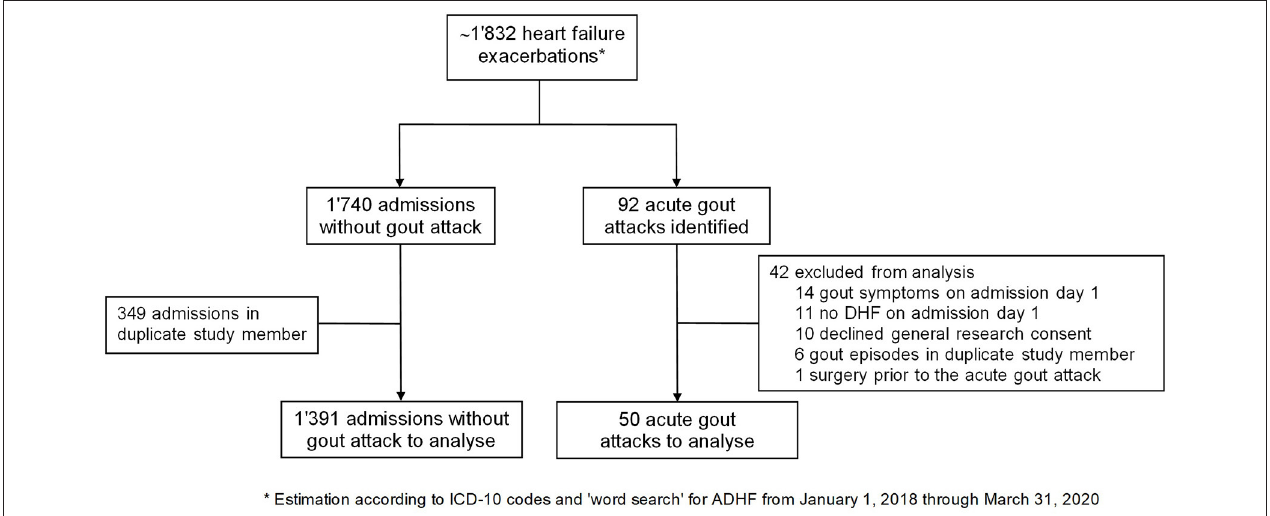
FIGURE 1 | Flowchart of patient selection. ADHF, acute decompensated heart failure; ICD, International Statistical